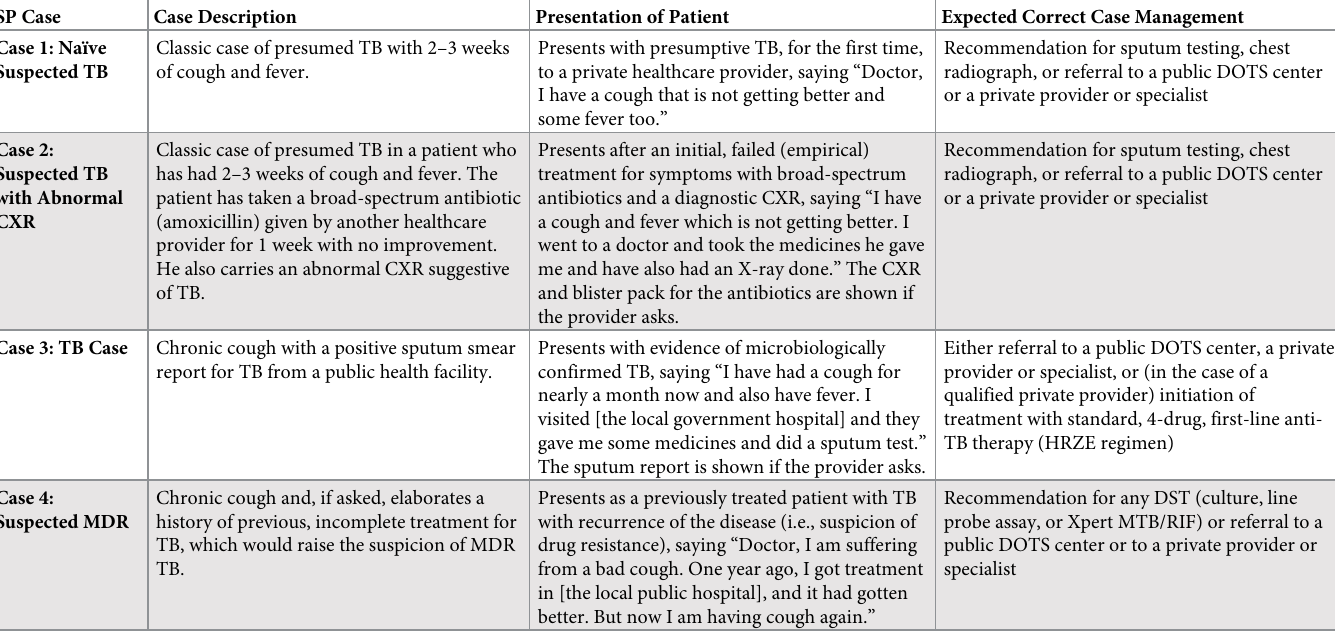
Table 2. SP case descriptions, patient presentations, and correct management